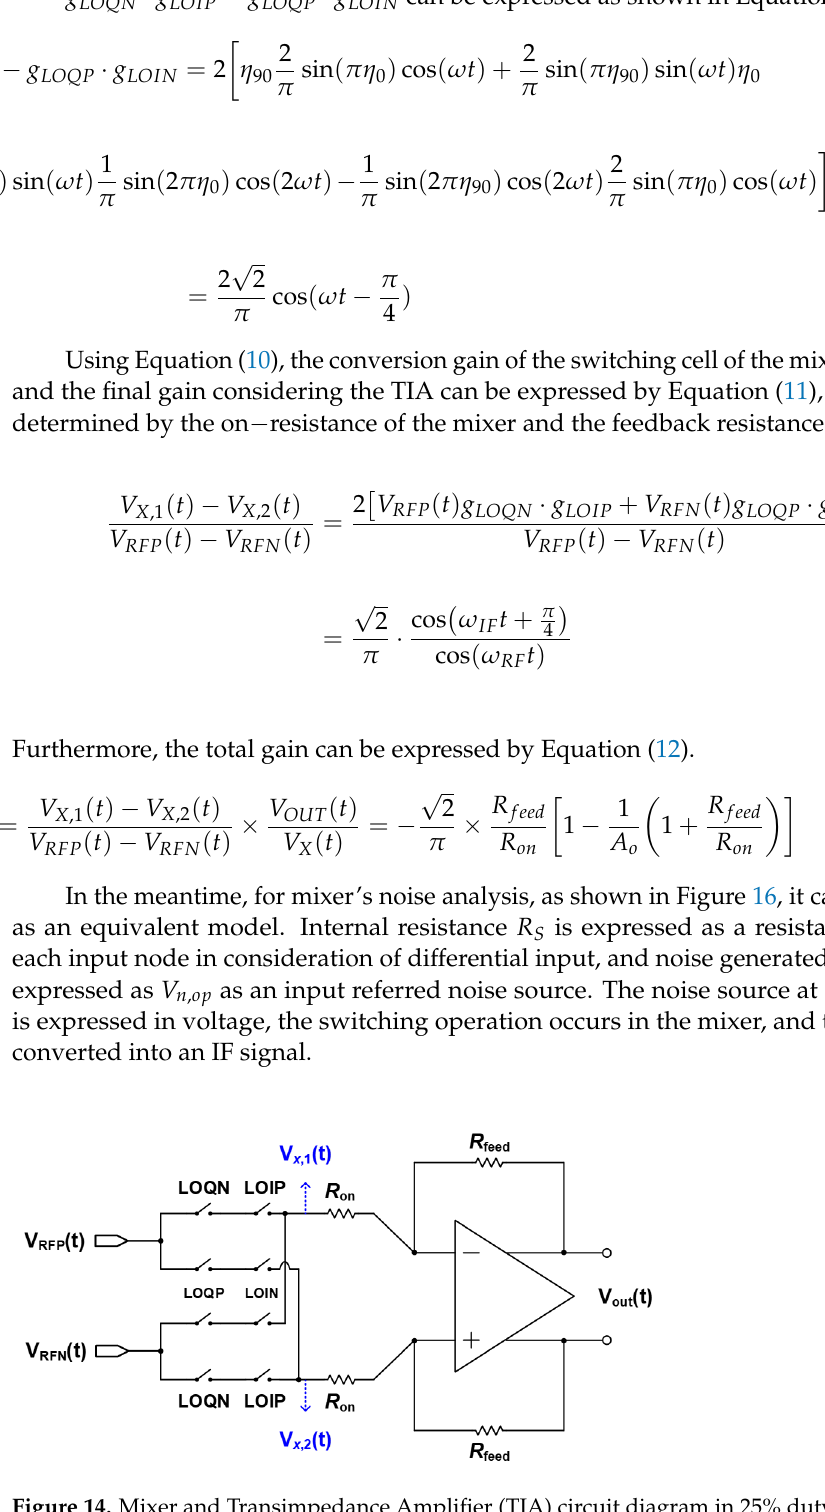
Figure 14. Mixer and Transimpedance Amplifier (TIA) circuit diagram in 25% duty